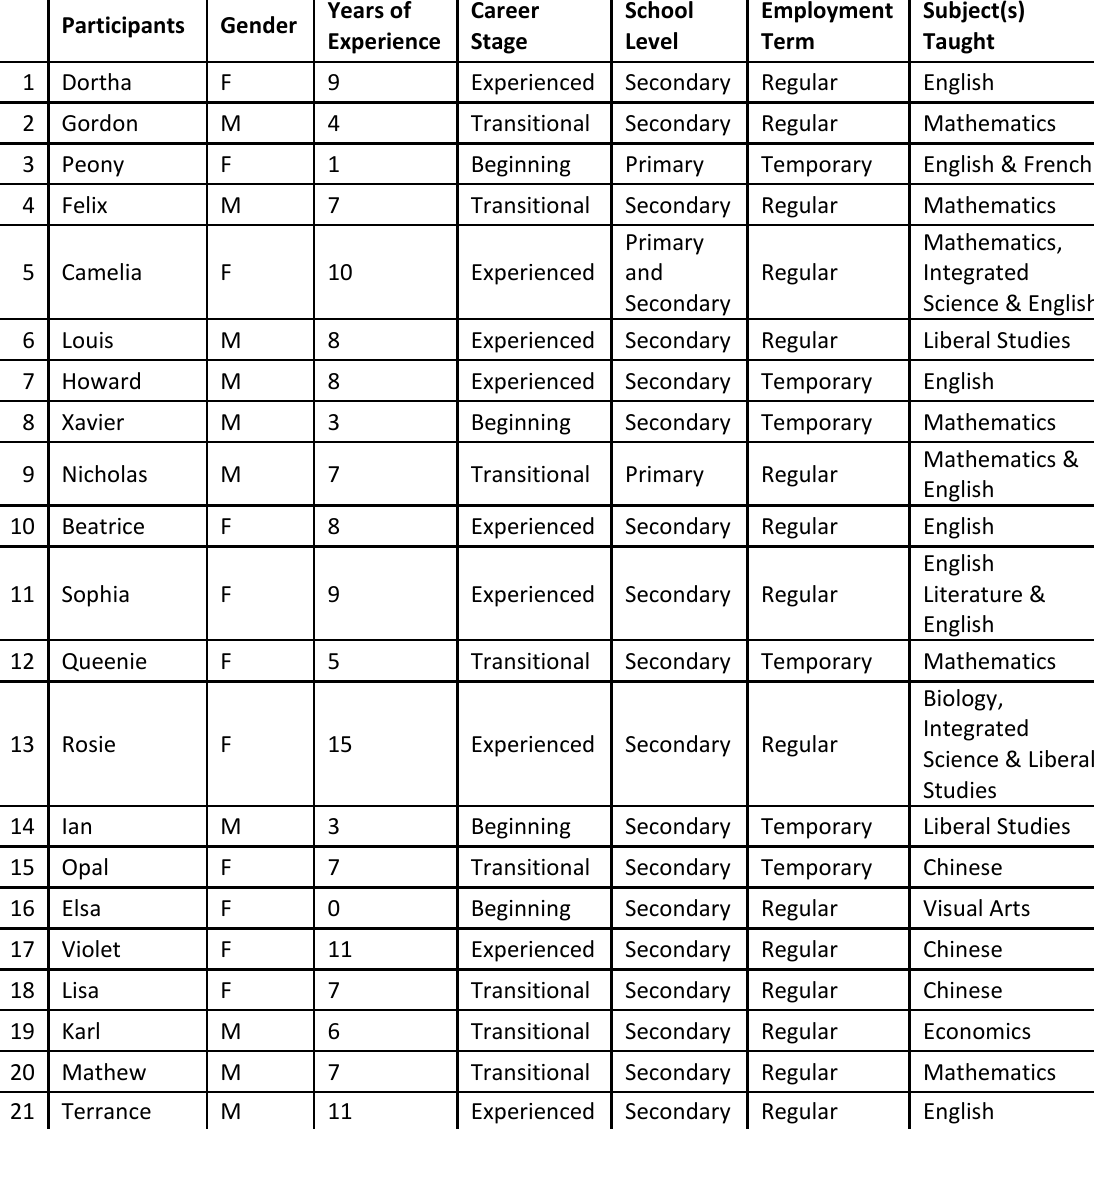
Table 1 . Background profiles of participants